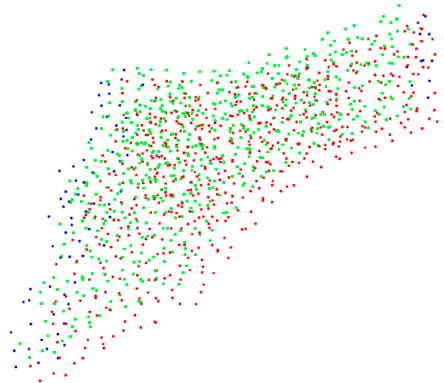
Figure 14. The parts with approximately the same shape obtained by the solution.